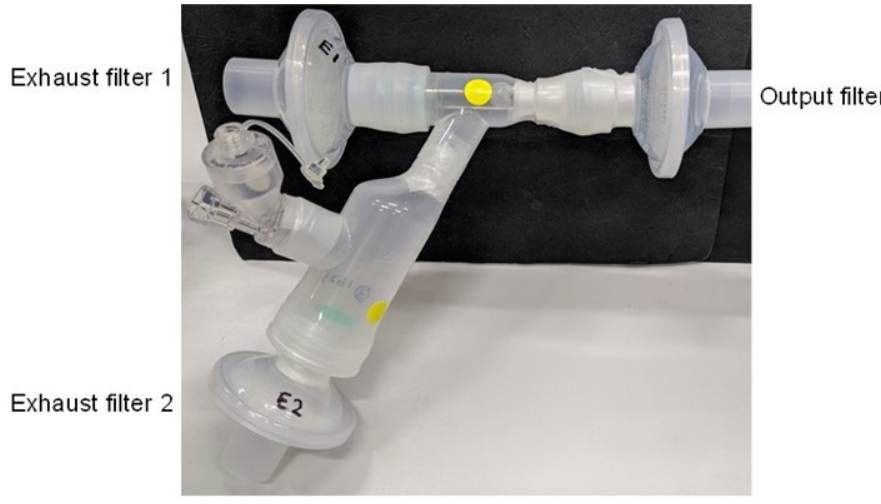
Figure 1. Setup for the dose output runs.